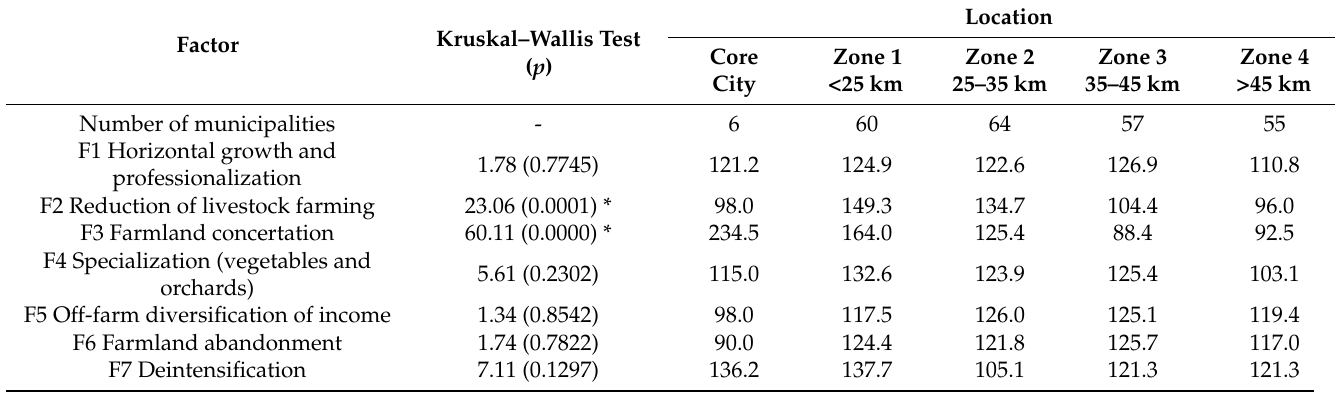
Table 4. Medium rank size for identified factors, depending on the